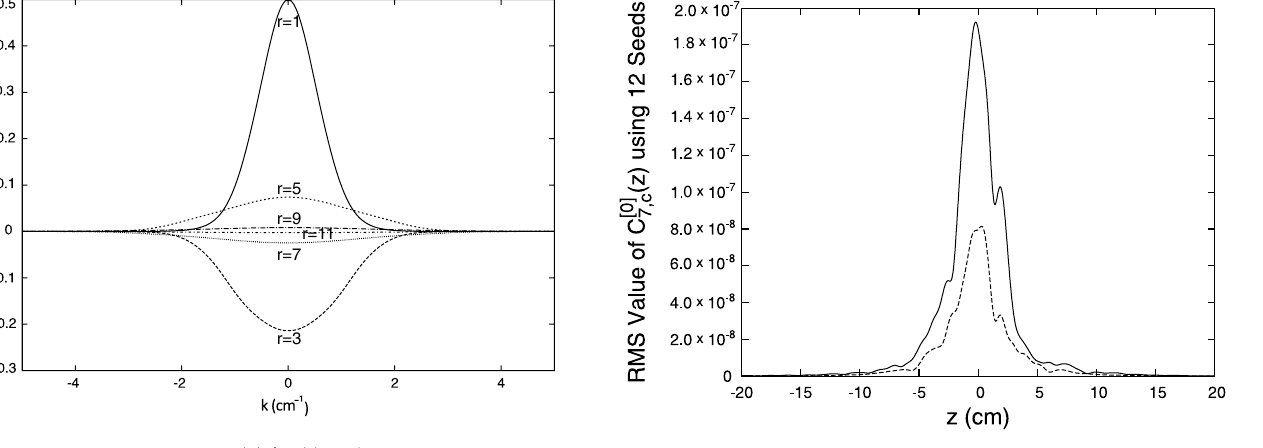
FIG. 20. The function C ½ 0 (cid:3) 7 as computed from a mesh contain- ;c ing random noise (61) at each mesh point. Damping of this noise illustrates the effect of smoothing. (solid line) Result obtained using a circular cylinder with R ¼ 2 cm . (dashed line) Result obtained using an elliptical cylinder with semiminor axis of 2 cm and a semimajor axis of 4 cm.